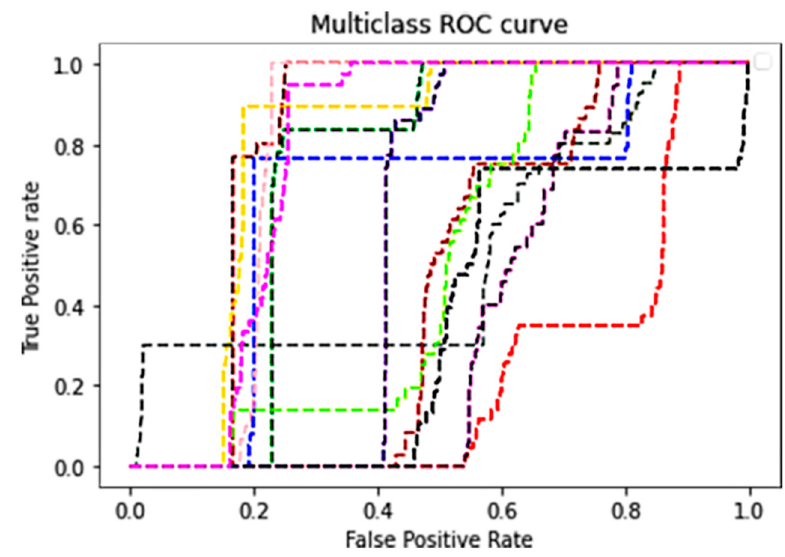
Figure 5. Multiclass ROC curve.